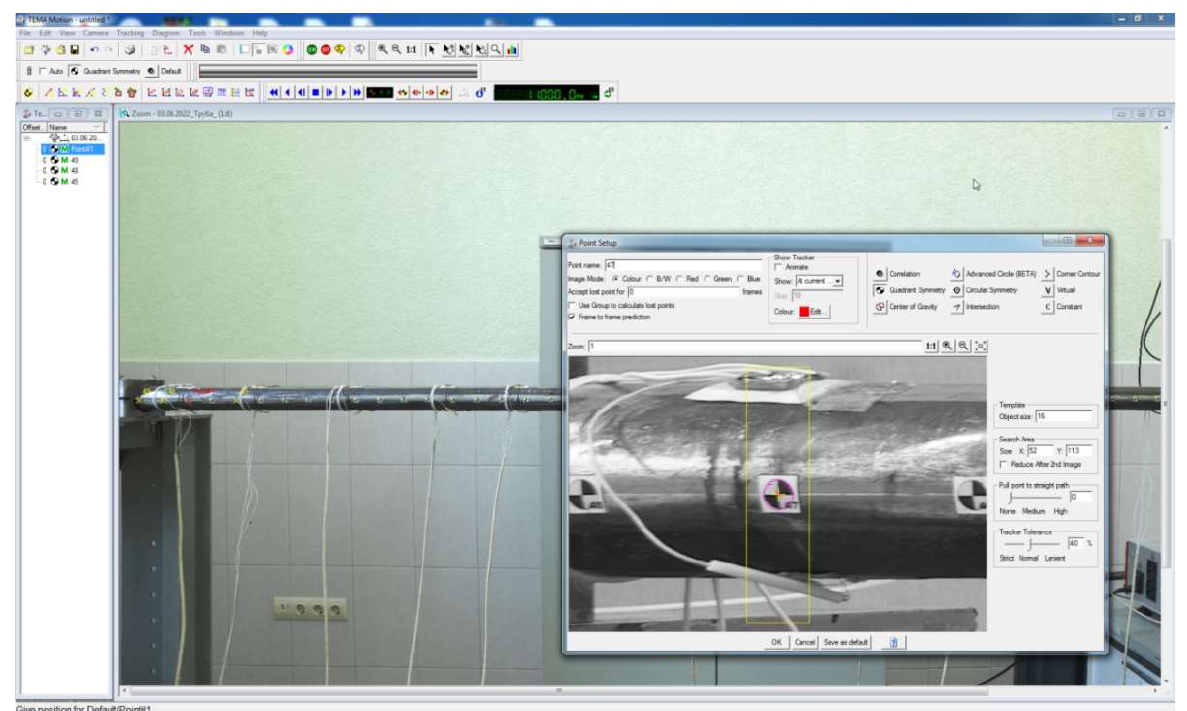
Figure 17. The ThemeMotion software interface.